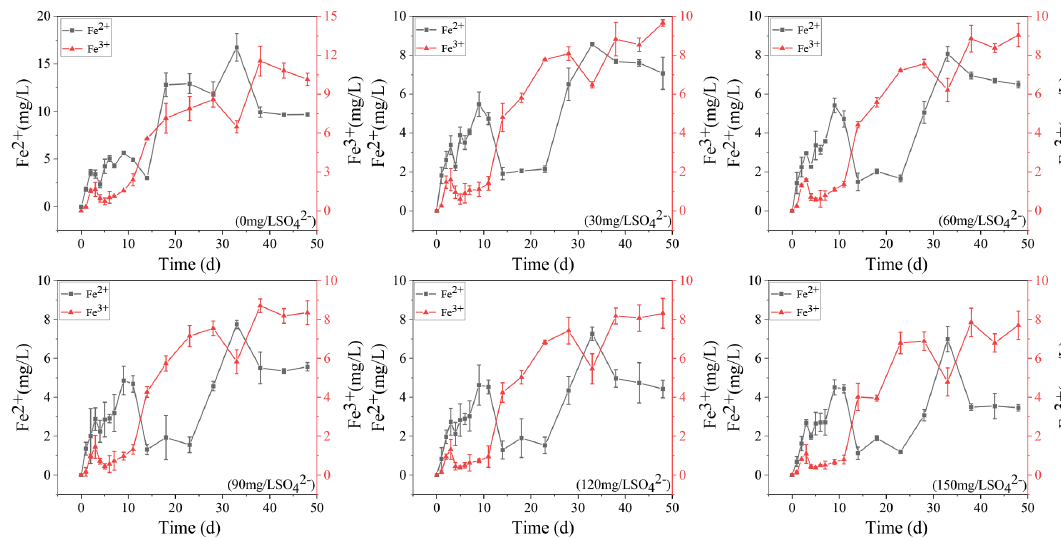
Figure 1. The concentration variations of Fe 2 + and Fe 3 + in the water column during the incubation.